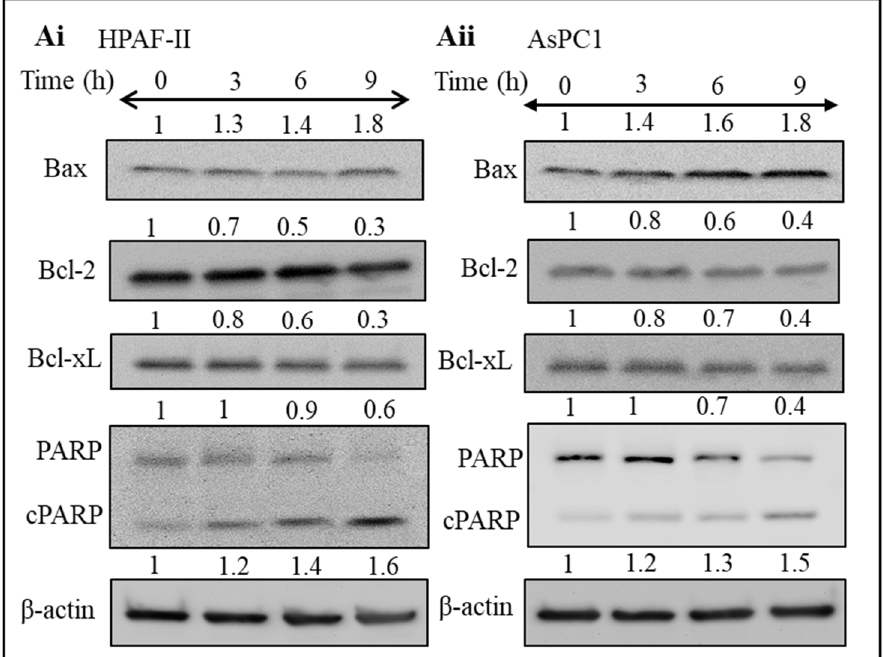
Figure 4. Steviol inhibits apoptosis in pancreatic cancer cells. ( A ) The expression level of important proteins associated with apoptotic pathway was evaluated in HPAF-II ( Ai ) and AsPC1 cells ( Aii ) of pancreatic cancer. Pancreatic cancer cells were treated with steviol (10 mM) at different time points (0, 3, 6, and 9 h), and Western blotting was conducted after preparation of cell lysates. Quantification of blots with respect to the loading control ( β -actin) was performed as depicted by the numbers above the bands.